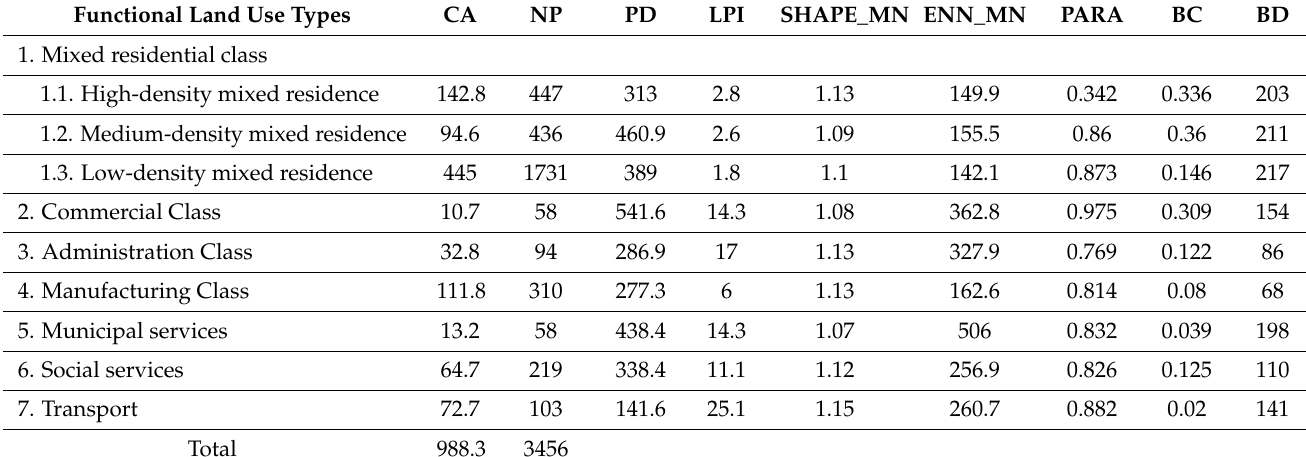
Table 8. Landscape metrics and urban form analysis